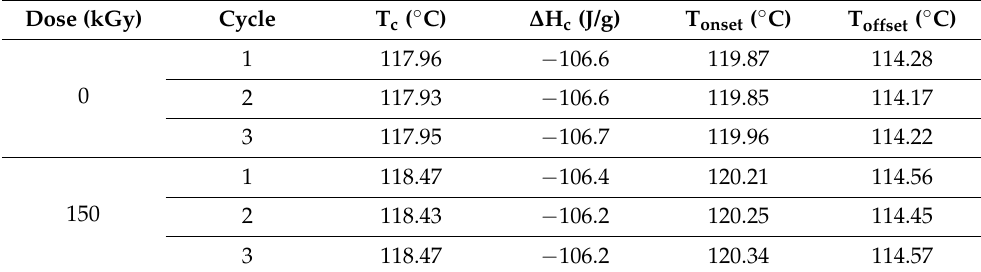
Table 7. Kinetic parameters of the crystallization curve of (CB + Gr)/(LLD + HD).